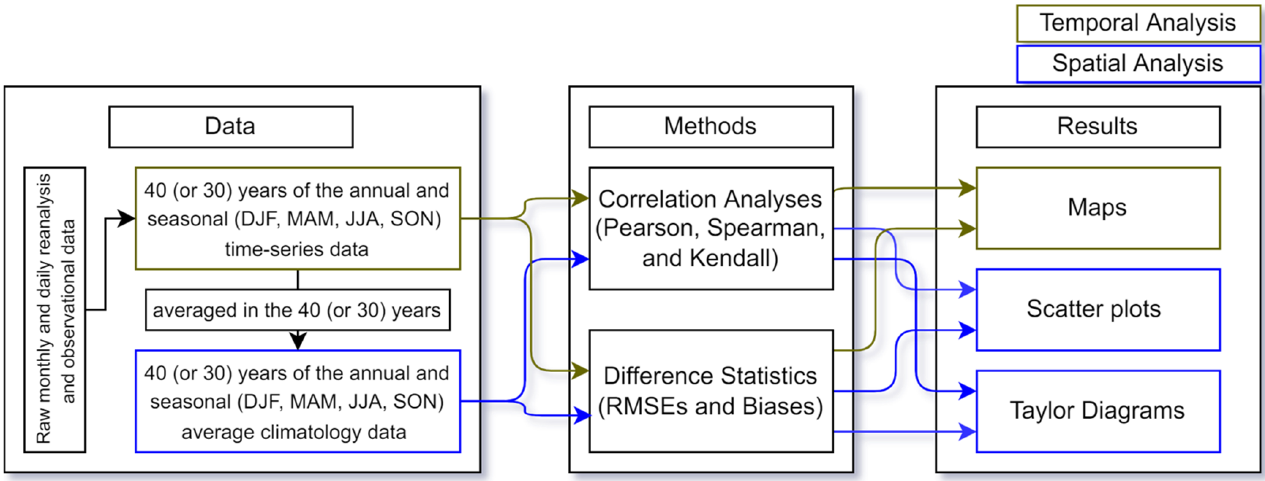
Figure 3. A schematic diagram of validation and comparison processes.